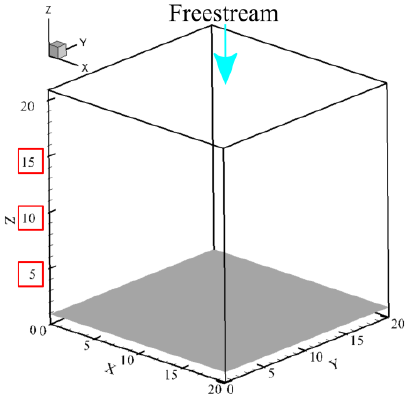
Figure 17. Computational domain used for the multiple-particle collisions with a flat wall (gray slab). Observation points are z = 5 D , 10 D and 15 D .